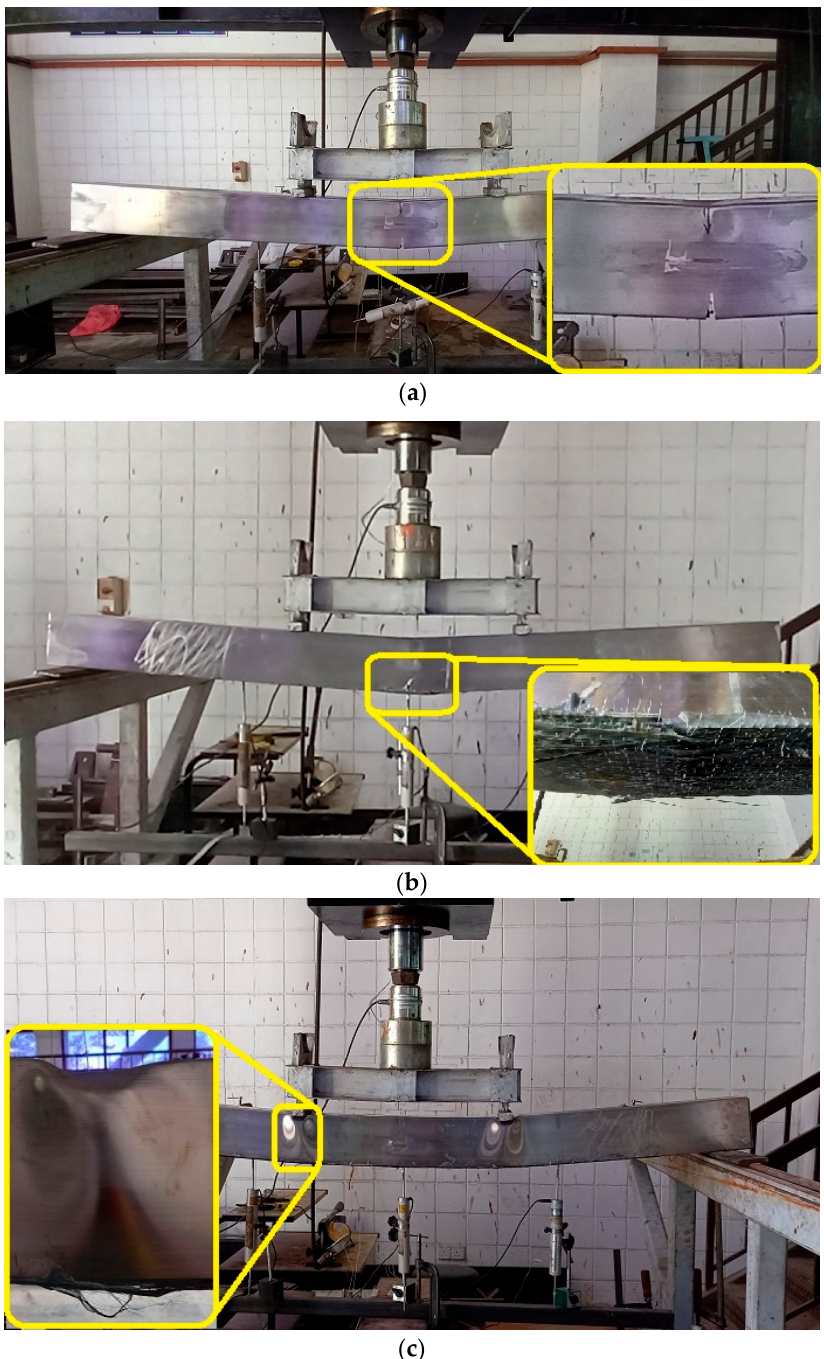
Figure 7. Typical strengthening behavior of RCFSST specimens with CFRP sheets. ( a ) MC-100-N;